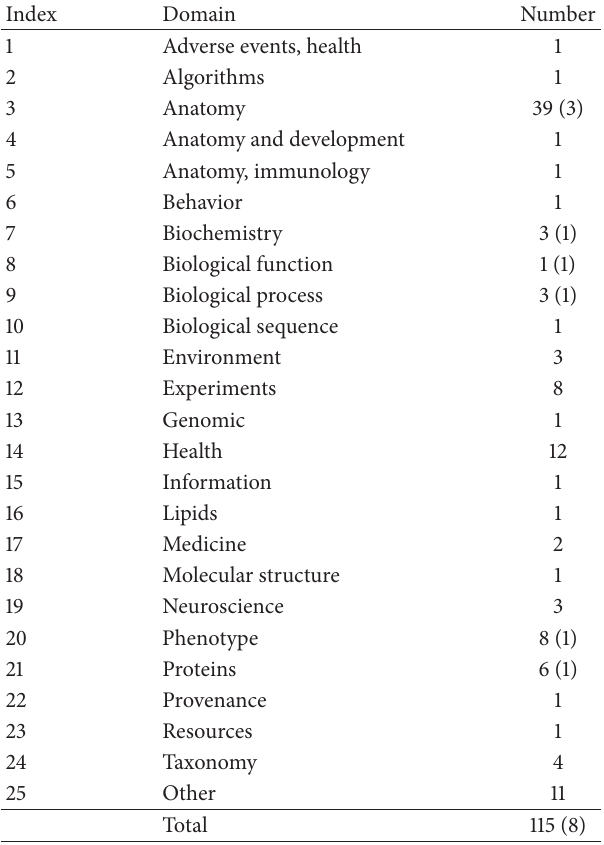
Table 1: Domains in the OBO